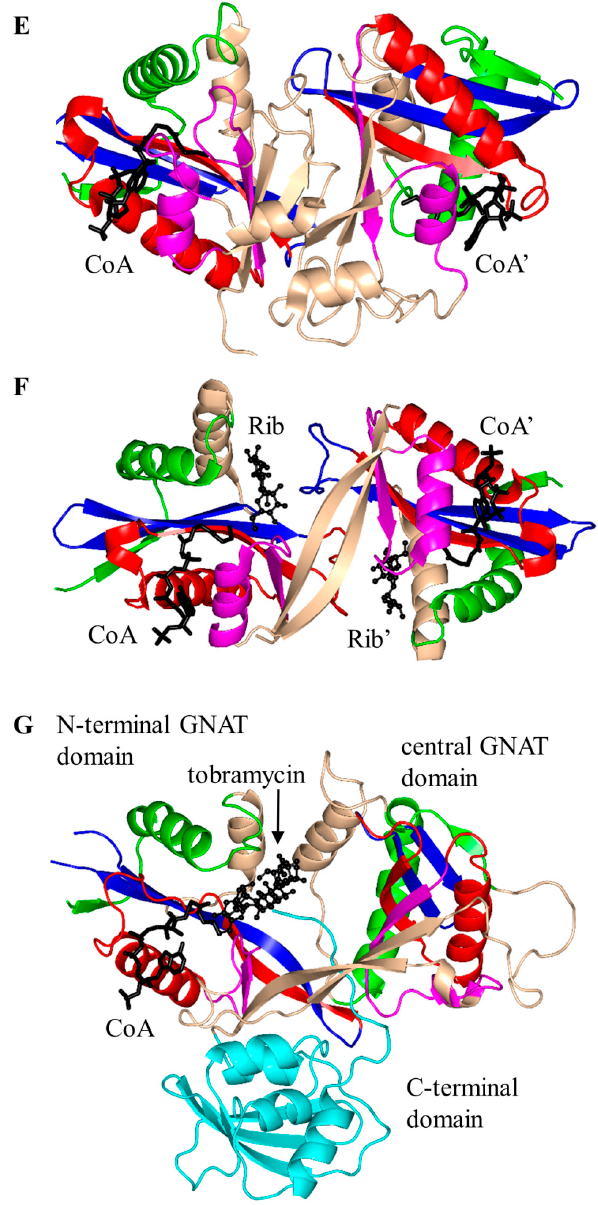
Figure 3. Cartoon representation of the structures of aminoglycoside N -acetyltransferases. ( A ) Aminoglycoside 2 ′ - N -acetyltransferase-Ic from Mycobacterium tuberculosis in complex with CoA and ribostamycin (Rib) (PDB ID: 1M4G [23]); ( B ) aminoglycoside 3- N -acetyltransferase-Ia from Serratia marcescens in complex with AcCoA (PDB ID: 1BO4 [5]); ( C ) aminoglycoside 6 ′ - N -acetyltransferase-Ib from Escherichia coli in complex with AcCoA and kanamycin C (KNC) (PDB ID: 1V0C [25]); ( D ) aminoglycoside 6 ′ - N -acetyltransferase-Ie from Staphylococcus warneri complex with a sulfinic acid form of coenzyme A (CoA) and kanamycin A (KAN) (PDB ID: 4QC6 [24]); ( E ) aminoglycoside 6 ′ - N -acetyltransferase-Ii from Enterococcus faecium in complex with CoA (PDB ID: 1N71 [34]); ( F ) Salmonella enterica aminoglycoside 6 ′ - N -acetyltransferase-Iy in complex with CoA and ribostamycin (Rib) (PDB ID: 1S3Z [39]); and ( G ) M. tuberculosis enhanced intracellular survival (Eis) in complex with CoA and tobramycin (PDB ID: 4JD6 [19]). The conserved and non-conserved motifs are colored as in Figure 1 (motif C—green, motif D—blue, motif A—red, motif B—magenta, non-conserved N-terminal and C-terminal regions—wheat). The C-terminal animal sterol carrier domain of Eis is colored cyan. The AcCoA/CoA cofactor is drawn as black sticks, whereas the substrates (tobramycin and kanamycin) are shown in black using ball-and-stick representation.